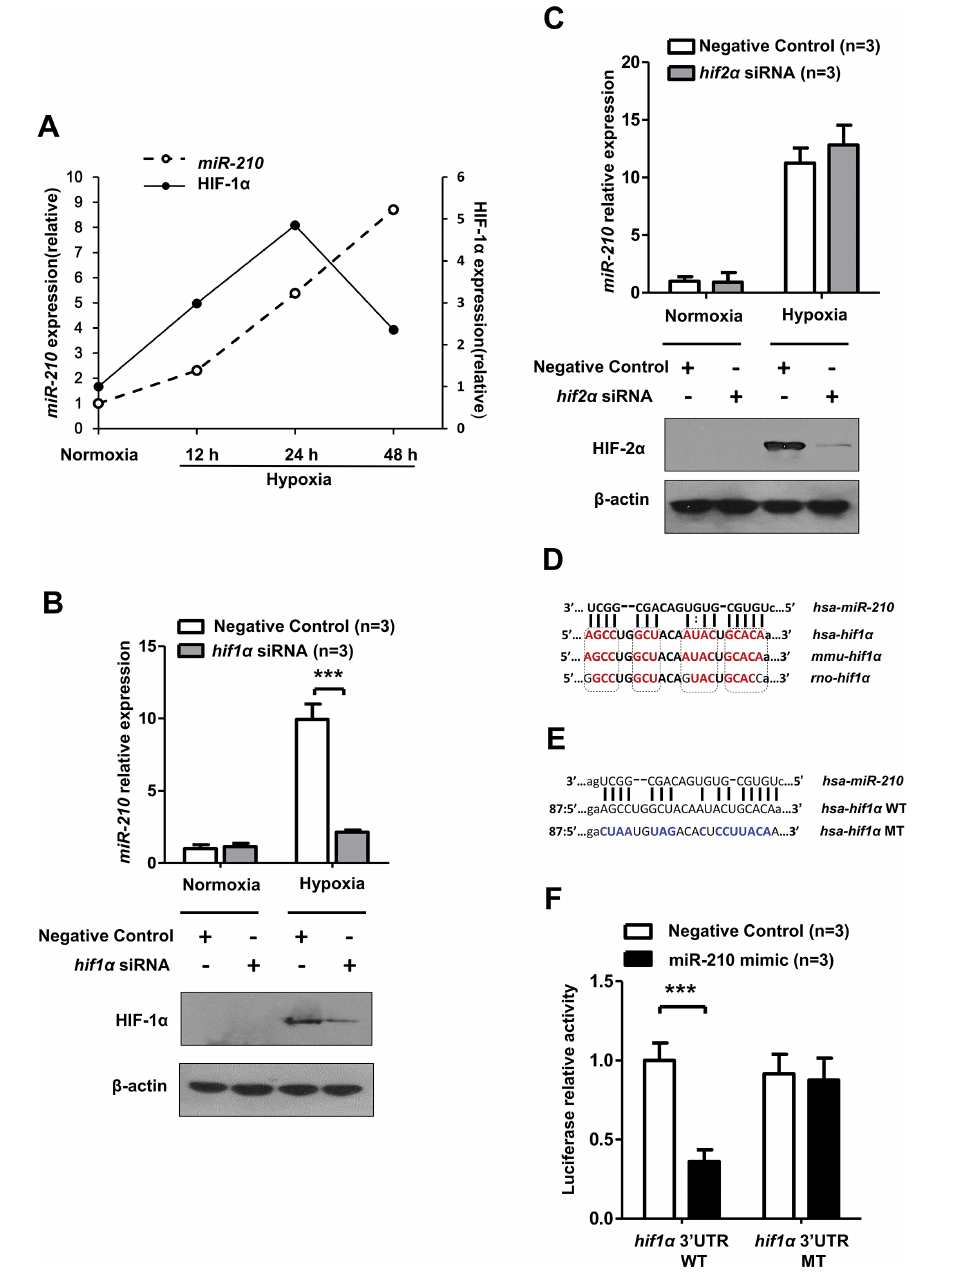
Figure 6. miR-210 targeted 3 ′ UTR of HIF-1 α mRNA directly. (A) The relevance of miR-210 and HIF-1 α protein expression in hypoxia-treated HK-2 cells (0.3% O ). The densitometry results for relative HIF-1 α protein expression were normalized to β -actin. Detection of miR-210 2 expression after (B) HIF-2 α and (C) HIF-1 α siRNA transfection and in HK-2 cells. miR-210 expression was normalized to RNU6. The predicted binding site of miR-210-3p in the 3 ′ UTR of human HIF-1 α mRNA was found at the microRNA.org website (www.microRNA.org). (D) The potential binding site of miR-210-3p in the 3 ′ UTR of HIF-1 α mRNA is highly conserved among the selected mammals. The high conserved bases are shown in red. (E) The mutant-type (MT) design of the miR-210-3p binding sequence in the 3 ′ UTR of human HIF-1 α mRNA. WT, wild-type. (F) Luciferase reporter assays were conducted to determine the impact of miR-210-3p mimic on the activity of the 3 ′ UTR of the human WT HIF-1 α or the 3 ′ UTR of the MT HIF-1 α luciferase plasmid in HK-2 cells. Luciferase activity data were obtained after normalizing the firefly luciferase value to the renilla luciferase value. All quantitative results are from three independent experiments and are shown as mean ± SD. The Western blot data are representative results from three independent experiments. * P < 0.05; ** P < 0.01; *** P <